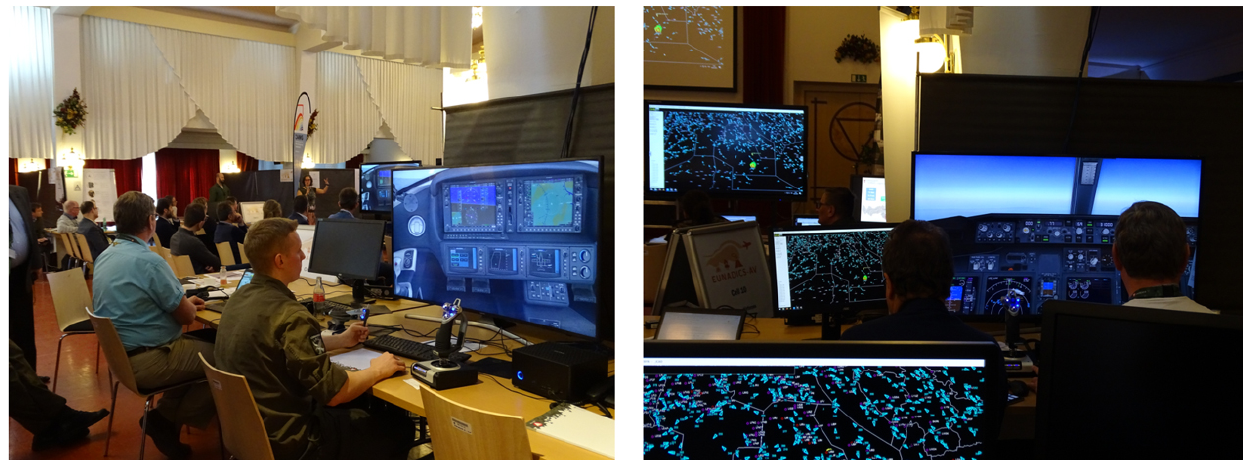
Figure 2. Selected photos from the demonstration exercise at the Schwarzenberg barracks in Salzburg. The flight simulator was operated by both military and civil